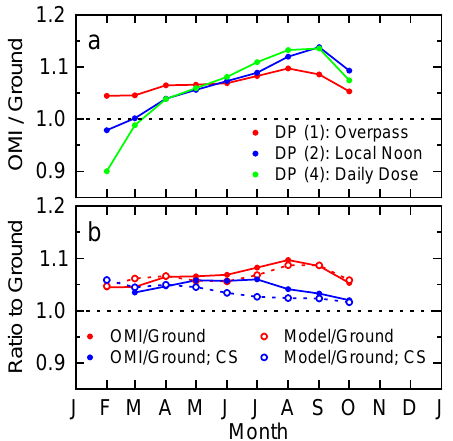
Figure 8. Comparison of OMI and ground data at Summit. Panel a: median ratios e ρ 1 , e ρ 2 , and e ρ 4 of DP (1), DP (2), and DP (4), re- spectively. Panel b: comparison of median ratios e ρ 1 of OMI and ground overpass measurements (solid symbols) with median ratios of modeled and measured data (open symbols). Results for data fil- tered for SZA < 84 ◦ and Dis; 12km are indicated in red. Results for data that were additionally filtered for clear-sky (CS) conditions are indicated in blue. The two data sets indicated by red solid symbols in Panels a and b are identical.